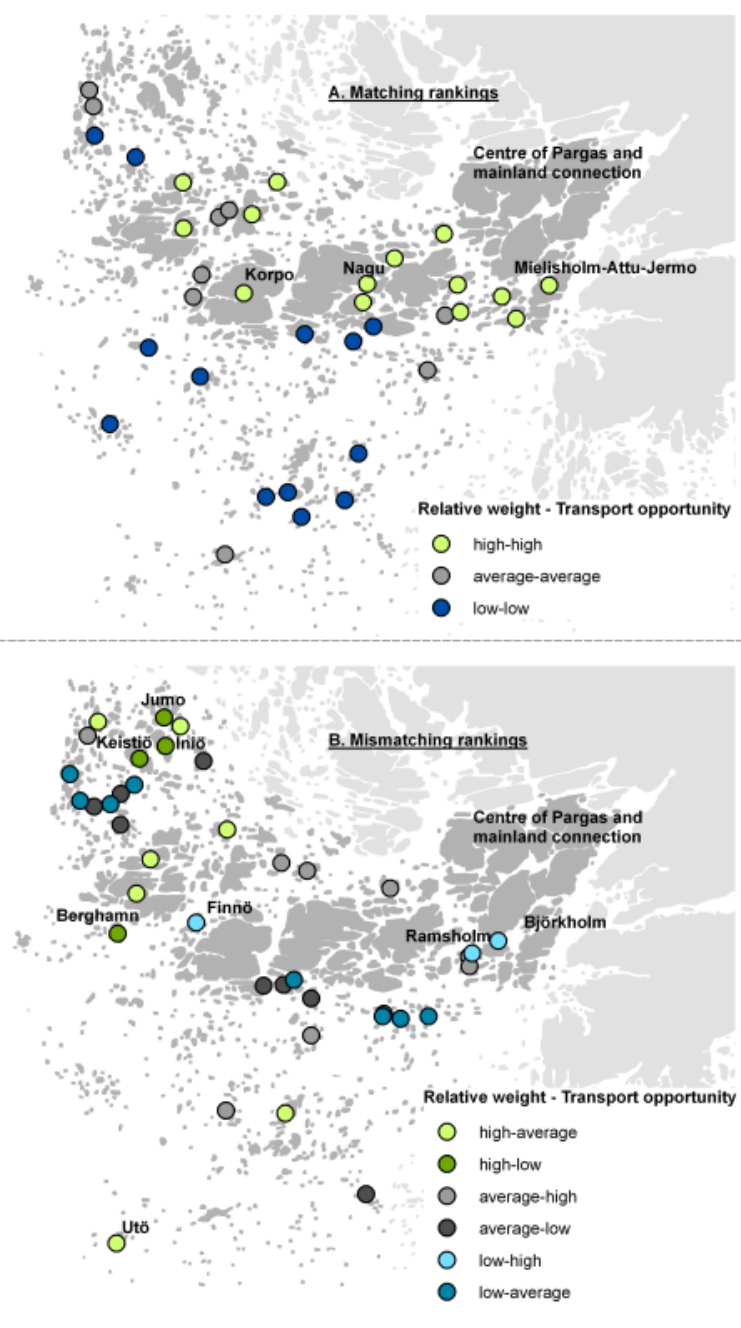
Figure 2. (A) Islands where the relative weight ranking and the transport opportunity ranking match. (B) Islands where the rankings do not match. Data sources: See caption in Figure